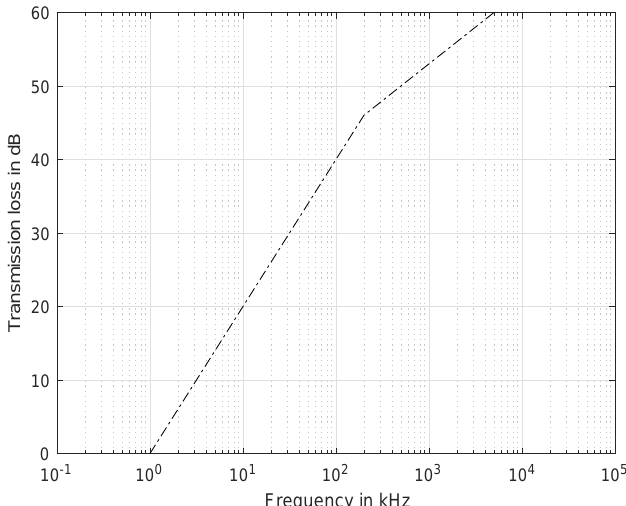
Figure 1. Transmission loss of acoustic